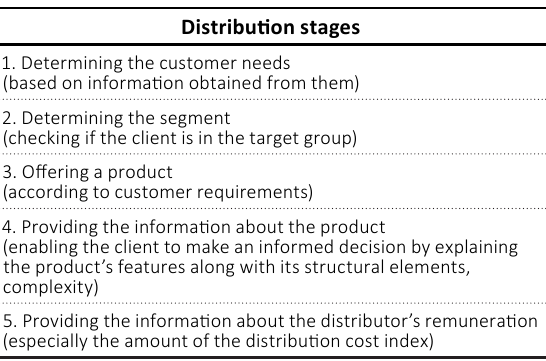
Table 2. Stages of performing the duties of a life insurance distributor in a new sales model